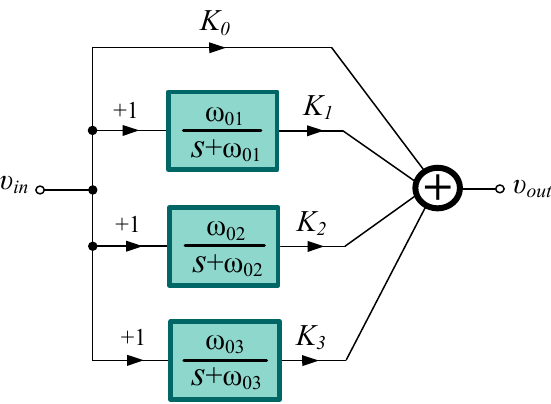
Figure 3. Functional block diagram for implementing (15). Table 2. Scaling factors and time constants for realizing the LP and HP power-law filters described by (14) for the coefficients of Table 1, using the PFE-based function in (15). PL LP/HP Filter Parameter β = 0.3 β = 0.5 β =